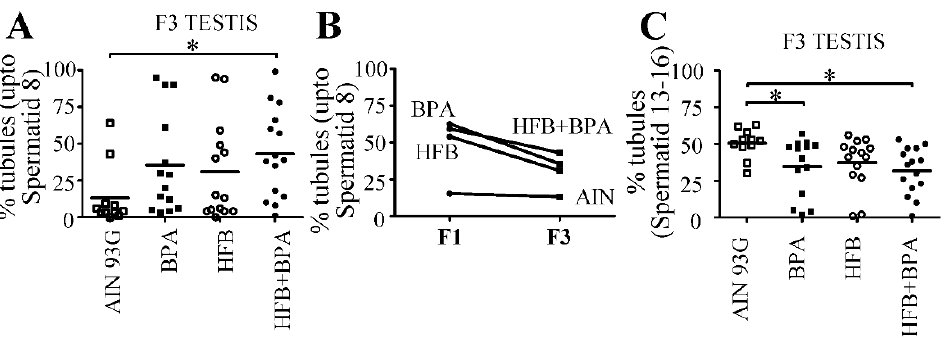
Figure 2. Semi-quantification of impaired spermatogenesis. Numbers of ( A , B ) STs with spermatogenesis up to round spermatid stage and ( C ) 13–16 spermatid stage were tallied for T + E2 − implanted F1 and F3 male offspring in diet groups as indicated. * p < 0.05 by one-way ANOVA between groups indicated, followed by Dunnett’s multiple comparison test. Each symbol represents one animal per litter. Two sections examined per animal.